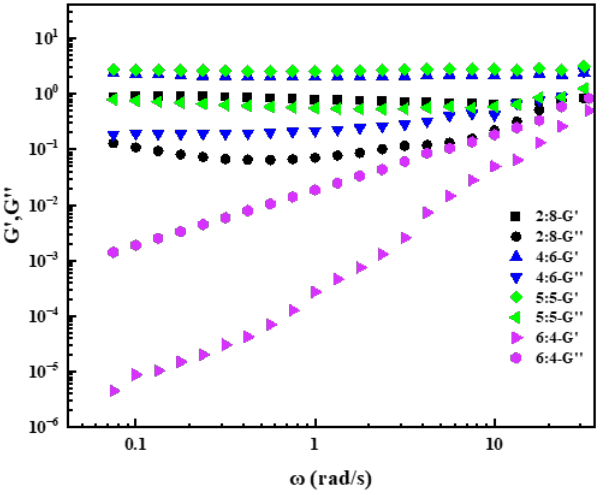
Figure 8. Dynamic viscoelasticity of GOHAC/NaPts gel solution at different radios (the total concentration of GOHAC and NaPts is 40